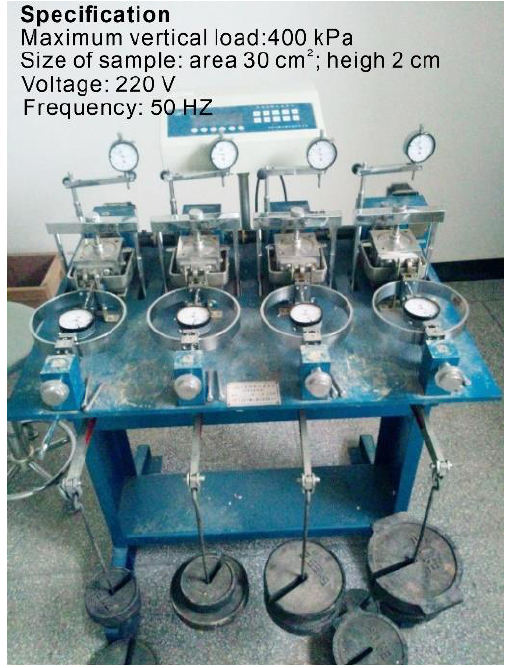
Figure 7. Indoor direct shear test apparatus.